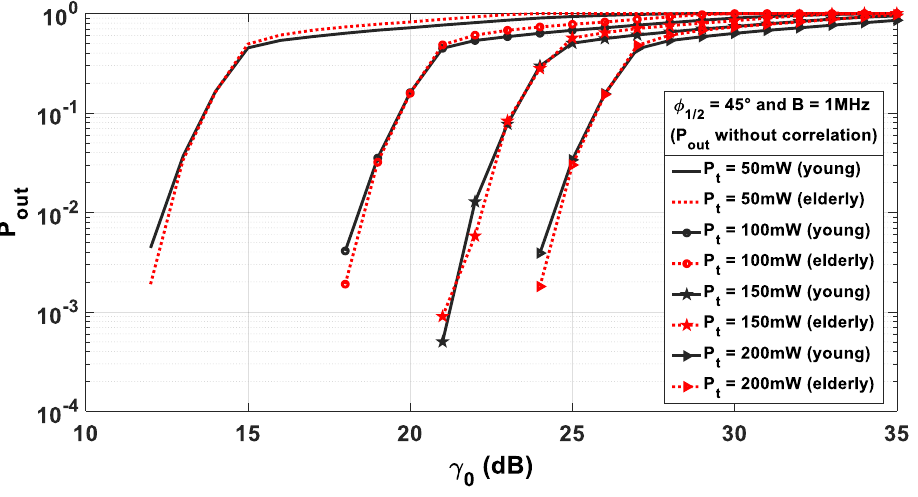
Figure 10. Uncorrelated outage probability 𝑃 𝑜𝑢𝑡 as a function of 𝛾 0 for different emitted